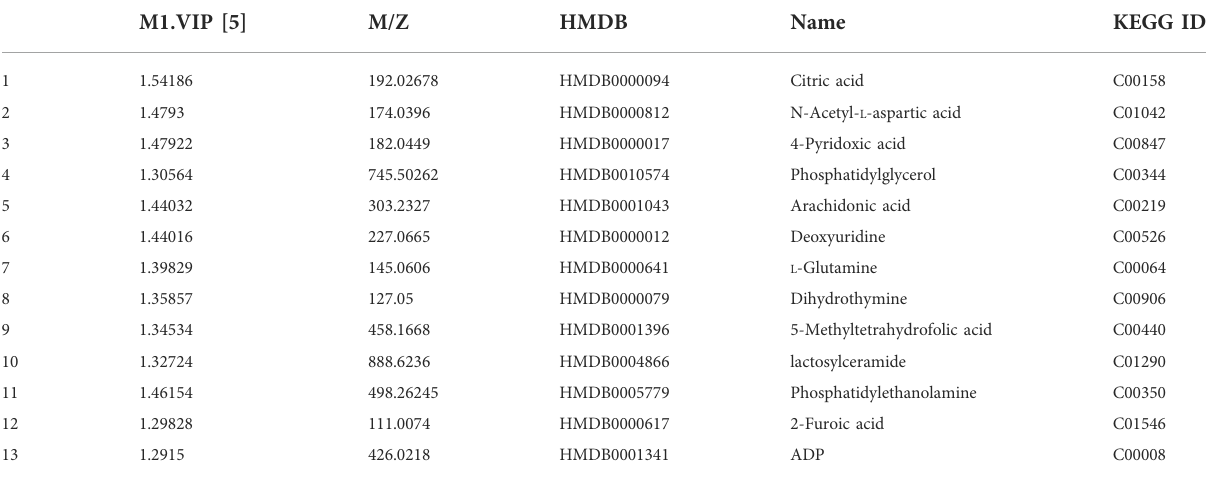
TABLE 1 Differential metabolites screen by